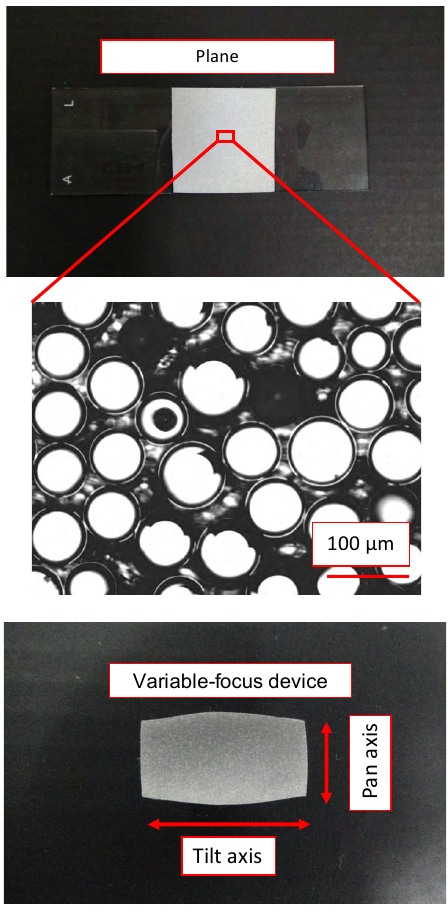
Figure 6. Observation object for evaluation